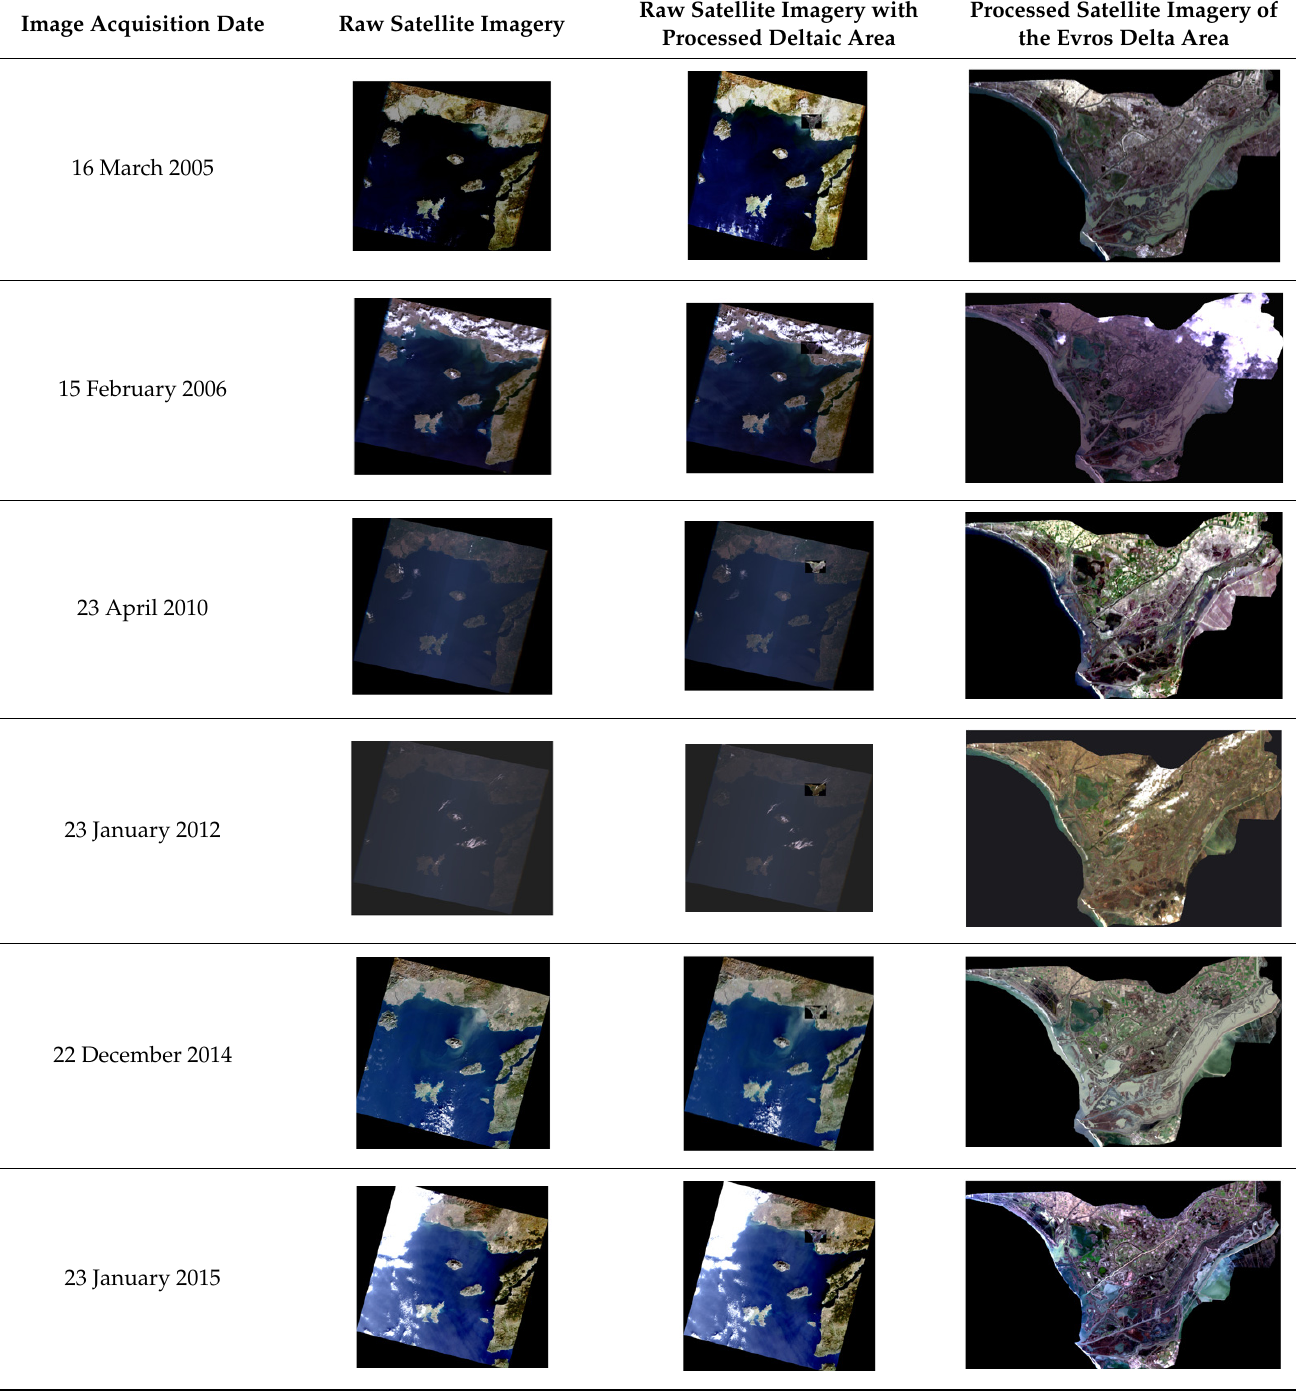
Table A1. Satellite images used in the study.